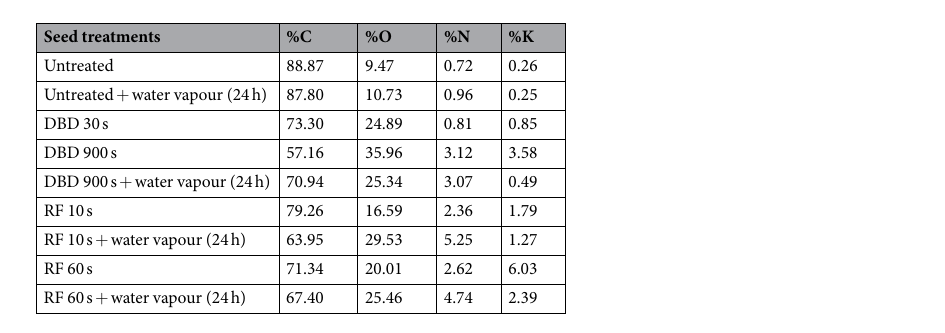
Table 1. Elemental surface composition in atom percentages for the Quinoa seeds subjected to different plasma and water exposure